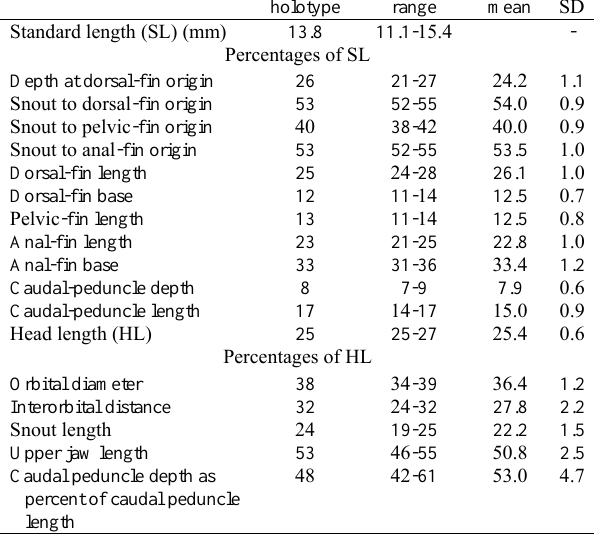
Table 1. Morphometric data of Priocharax nanus (n=25, except for anal-fin length with n=23, range does not include holotype); SD = Standard Deviation.